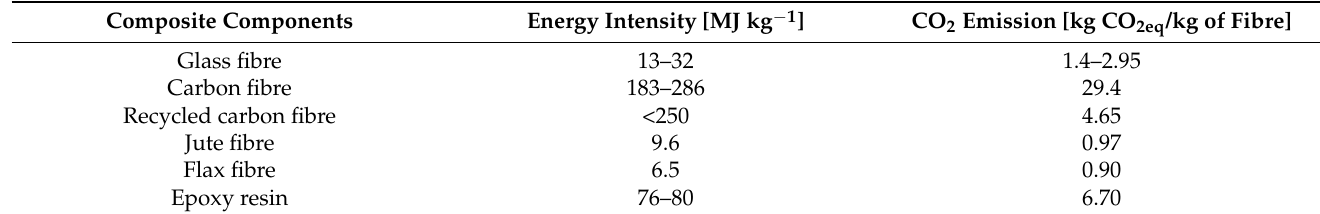
Table 3. Carbon footprints of FRP composite components: natural and synthetic fibres and conven- tional epoxy resin polymer (data reproduced from [55]). (< is the “less-than sign”).